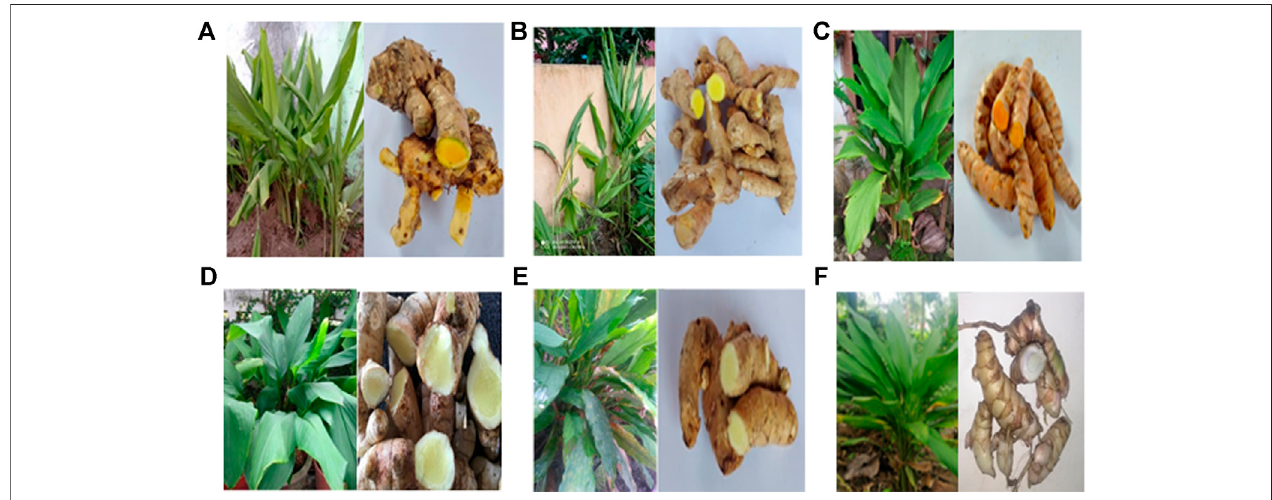
FIGURE 1 | Plants and rhizomes of Curcuma species. (A) Cucuma zanthorrhiza , (B) Curcuma mangga , (C) Curcuma longa , (D) Curcuma amada (Art fi re, 2016; Snapdeal, 2020), (E) Curcuma zedoaria , and (F) Curcuma aeruginosa.